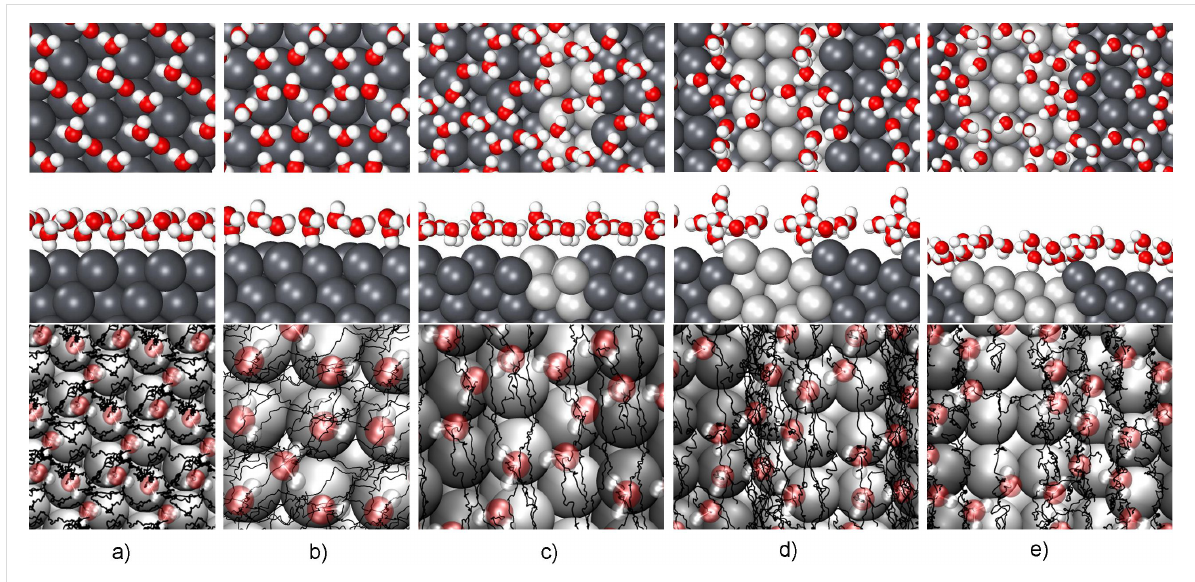
Figure 5: Upper two panels: Snapshots of the AIMD simulation of water layers at a temperature of 140 K on a) Pb(111), b) Pb(100), c) Pb(311) d) Pb(511) and e) Pb(711) in top and side view; lower panel: trajectories of the oxygen atoms of the water molecules along the AIMD run indicated by black lines. For Pb(111) and Pb(100), the water coverages correspond to the most stable flat water structures, i.e., 1 and 5/4, respectively.